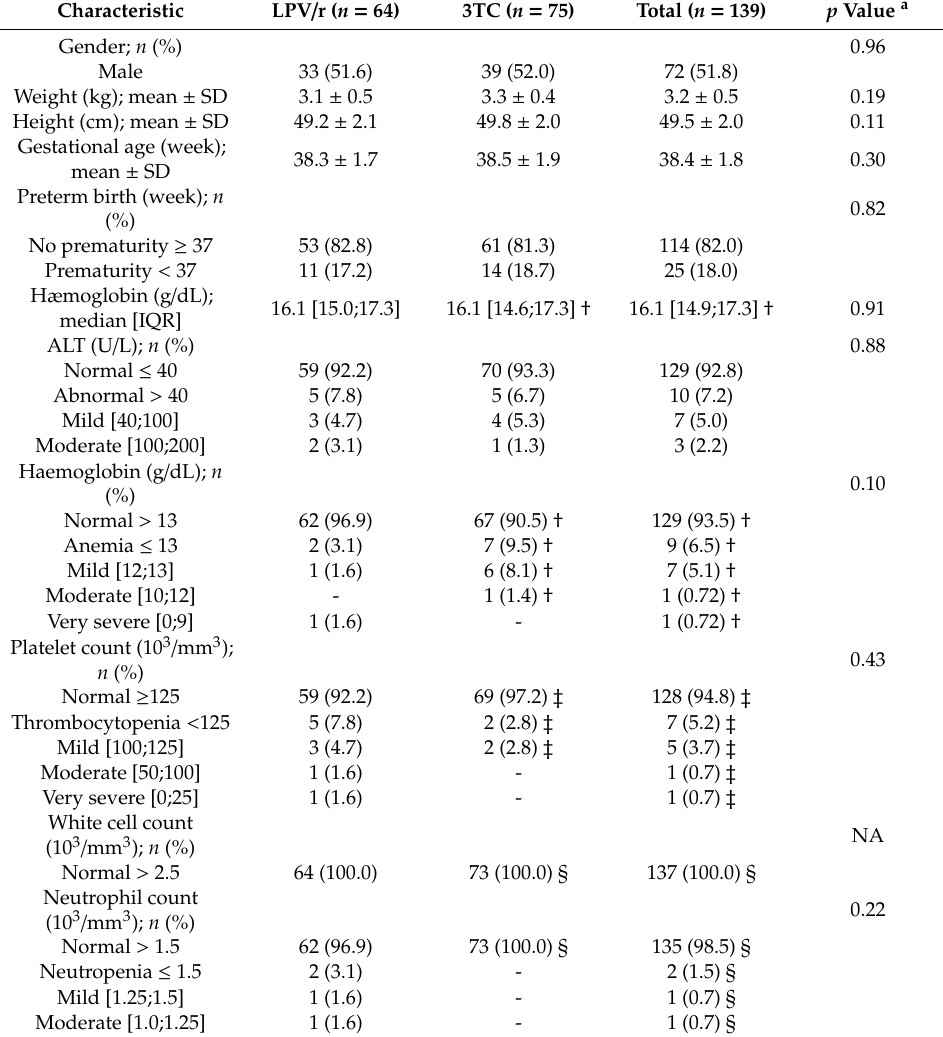
Table 1. Children’s characteristics at PrEP randomisation